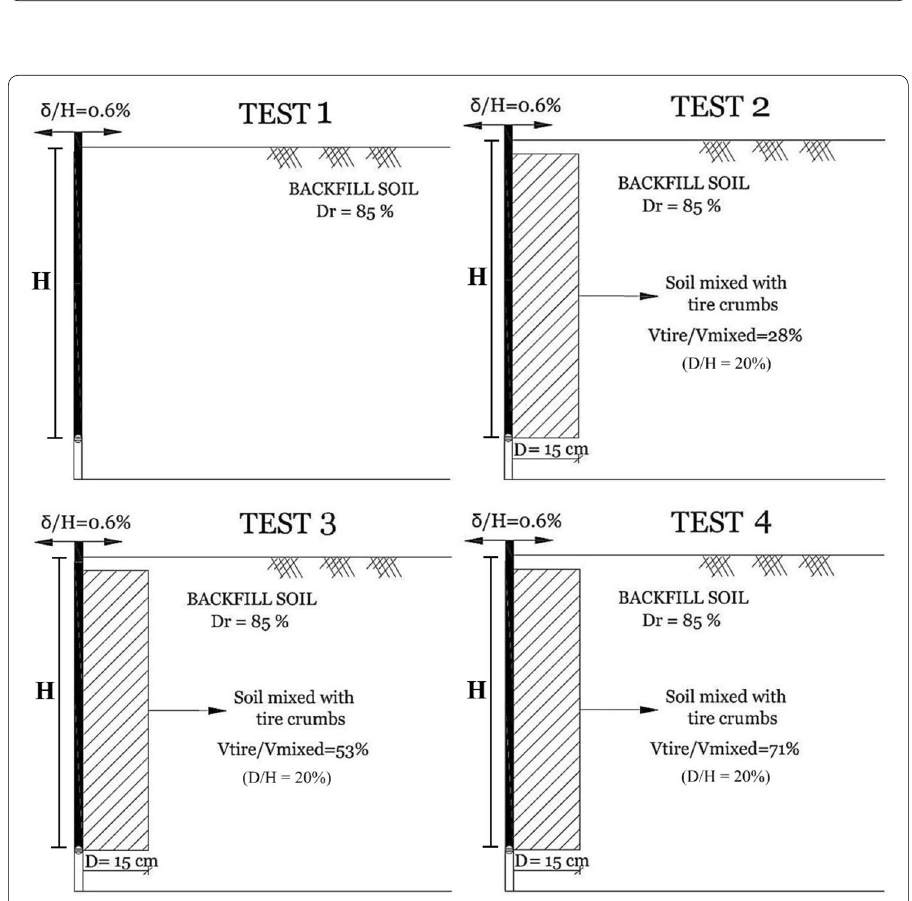
Fig. 10 Schematic view of the 4 tests, with 4 different tire/area volume